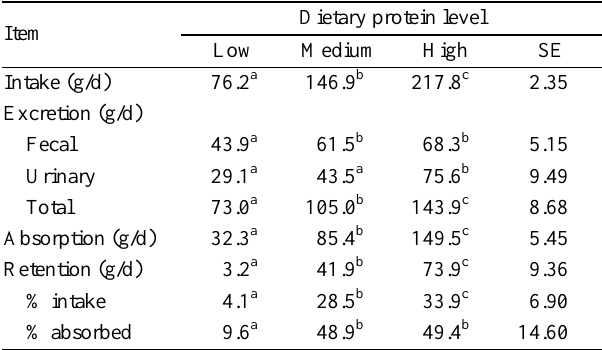
Table 3. The dietary CP intake linearly increased (p<0.05) as dietary CP increased. The linear increase in CP intake resulted in a linear increase of CP in total fecal and urinary